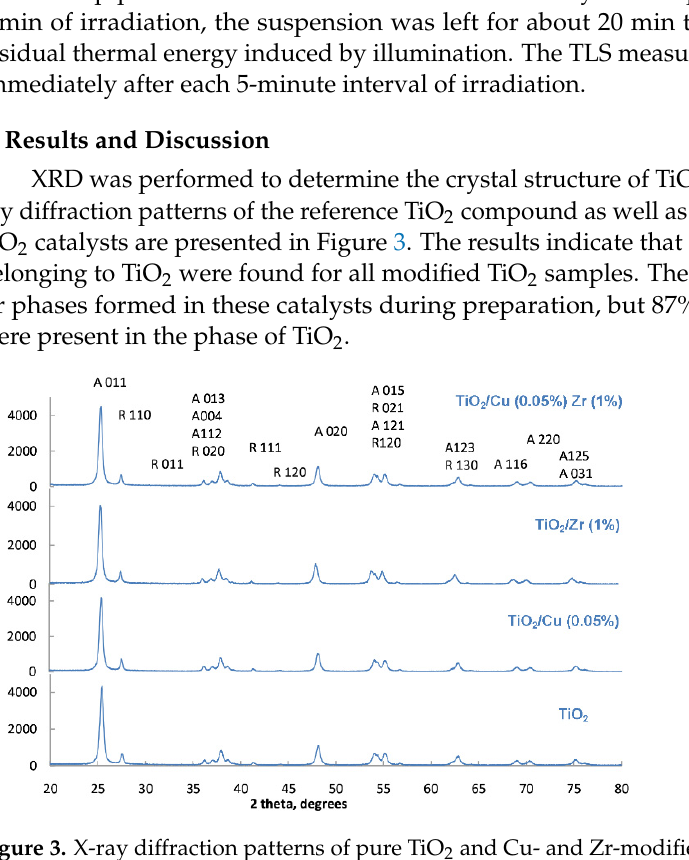
Figure 4. Qualitative EDX spectra of ( a ) unmodified TiO 2 and ( b ) P25/Zr (1%)/Cu (0.05). Figure 5. STEM-EDX mapping of Cu- and Zr-modified TiO 2 /Cu (0.05%)/Zr (1%) photocatalyst. To examine the band gap of TiO 2 materials, the absorption spectra were recorded and expressed as log α = f( λ ), where α is the absorption coefficient and λ is the wavelength